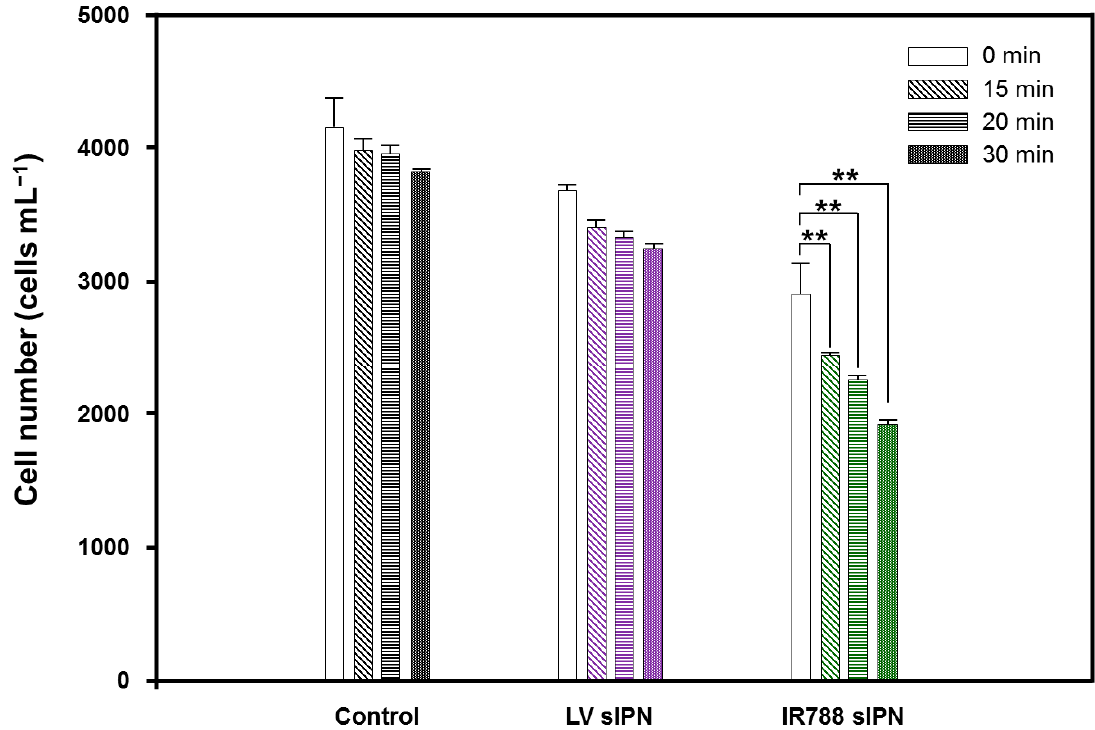
Figure 6. Effect of laser irradiation (808 nm) under 1.5 W/cm 2 on Akashiwo sanguinea treated with LV- and IR788-sIPN NPs at different irradiation time. One-way ANOVA, mean ± SEM, ** p < 0.01. After 30 min of laser irradiation, the cells of the control group decreased by 7%. Laser irradiation had no significant effect on the control cell due to NP absence. On the other hand, the cell number of the experimental group that was exposed to LV-sIPN NP decreased by 14% after irradiation for 30 min. IR788-sIPN NP showed the highest number of cells decreased compared to both control and LV-sIPN NP, which was 32% with 30 min of irradiation time. This observation suggests that Ak. sanguinea was removed by the material loaded inside the NP. IR788 inside the NP affects microalgae cells as a photothermal material that generates heat by the photoexcitation when it is exposed to NIR wavelength light. Next, to determine the effect of accumulated light energy on Ak. sanguinea , IR788-sIPN NP-treated Ak. sanguinea cells were irradiated for 10, 30, 45, and 60 min at 808 nm laser with different power, under 1.0 and 0.5 W/cm 2 . In all cases, algal cell numbers gradually decreased with increasing laser exposed time. Figure 7 shows the effect of laser irradiation on both NP-treated cells and control including cell decrease percentage at different irradiation times. The highest number of cells decreased for the control plate was 8% and 4% for 1.0 and 0.5 W/cm 2 with 60 min of irradiation time respectively. In contrast, the experimental group treated with IR788-sIPN NP uptake showed that the number of cells decreased up to 28% and 11%. This trend in cell decrease can be significantly seen after 45 min of